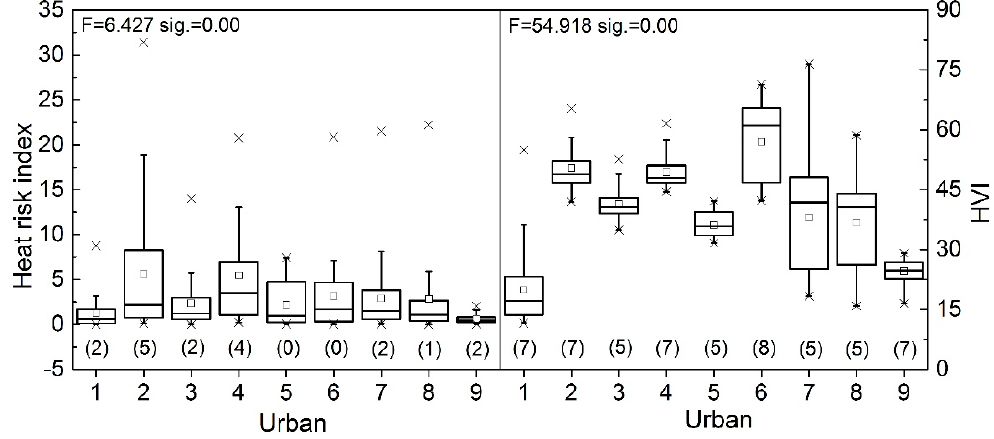
Figure 9. Comparing nine main urban areas (horizontal indexes 1–9 refer to Pingxiang, Yichun, Xinyu, Fuzhou, Yingtan, Shangrao, Nanchang, Jingdezhen and Jiujiang). The boxes represent the 25th to the 75th percentile; the crosses are the maximum and minimum values. The number in bracket is the quantity of urban regions that are significantly different from the urban of the corresponding horizontal index. The significance level is 0.05.